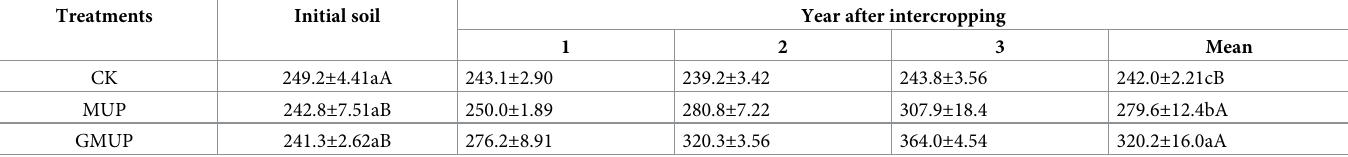
Table 4. Non-hydrolyzable nitrogen content of different treatments in the initial soil and the soil after three intercropping years (mg � kg -1 ).